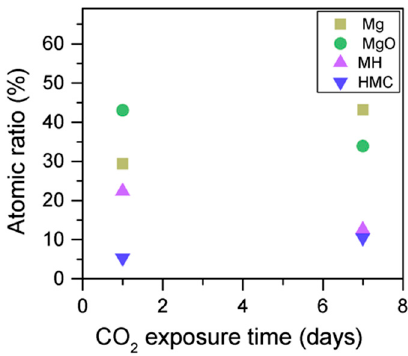
Figure 12. Mg2p BE for samples exposed to 10% CO 2 for one and seven days.